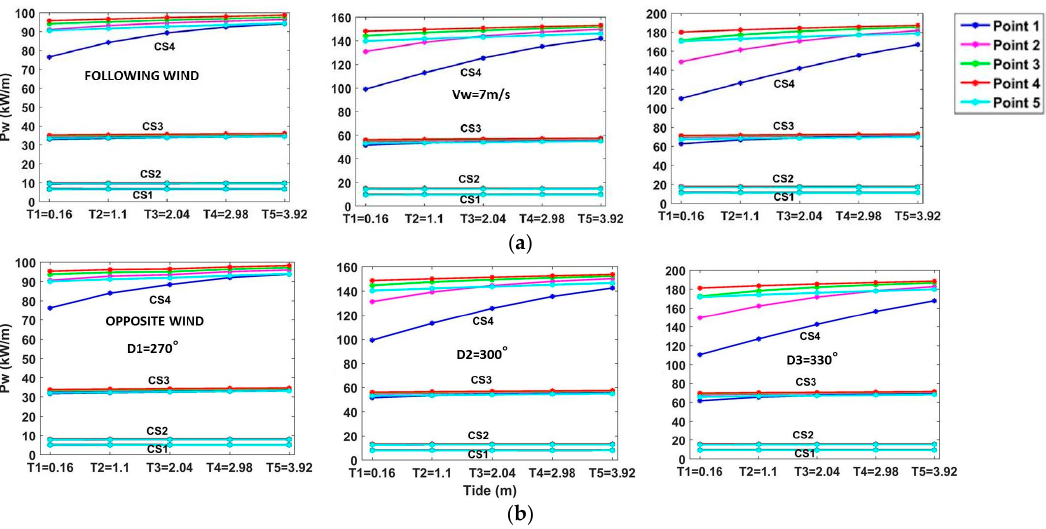
Figure 14. Average wind conditions ( V w = 7 m/s), P w variations along the reference points corresponding to the three different directions of the incoming waves (D1, D2, D3) and to the five tide conditions (T1, T2, T3, T4, and T5) for all the case studies considered (CS1, CS2, CS3, CS4): ( a ) following wind; and ( b ) opposite wind. Table 7. SWAN results for CS4, corresponding to the reference points P3, P4, and P5, the tide levels T1 and T5, and the wind conditions W0, W7, and W22, in terms of the wave parameters H s , H sw , and P w .